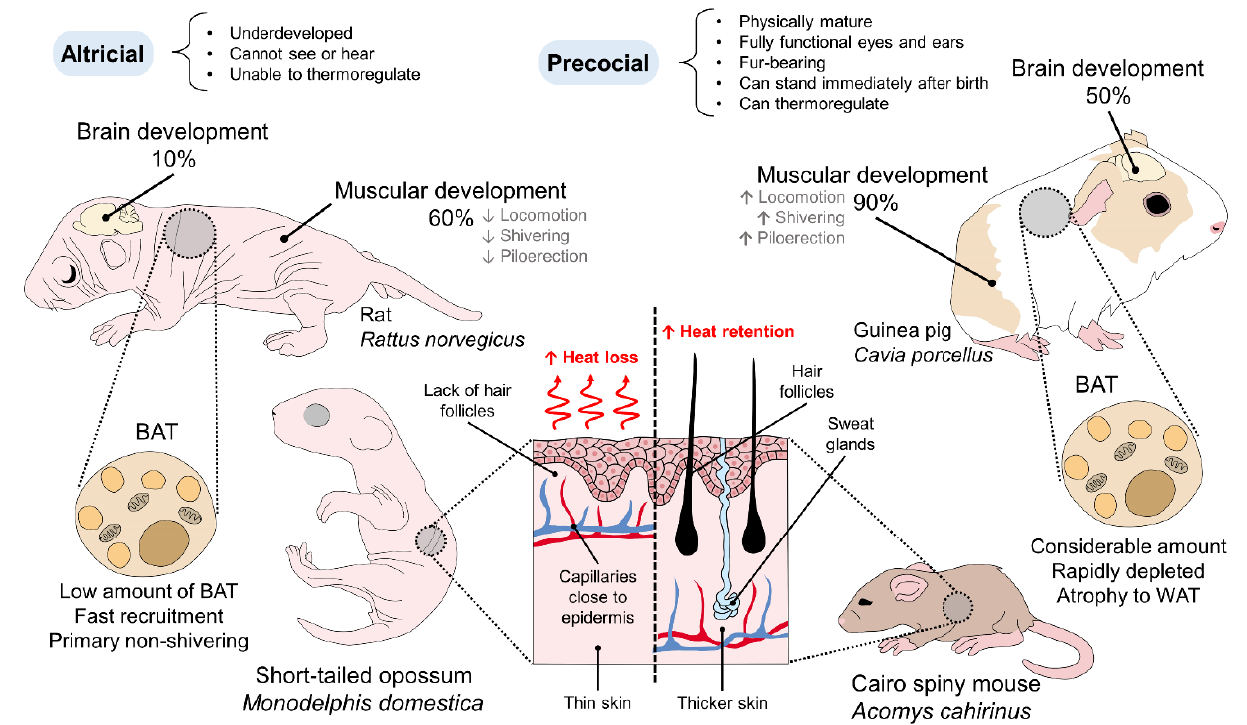
Figure 2. Morphoanatomical differences in altricial and precocial newborn rodents and their influence on thermoregulation. In altricial or underdeveloped Monodelphis domestica and Rattus norvegicus ) and precocial or physically mature species ( Cavia porcellus, Acomys cahirinus ), morphological characteristics promote or hinder thermoregulation. The lack of fur, low amounts of BAT, uncoordinated locomotion, and thin skin with capillaries close to the epidermis contribute to heat loss and susceptibility to hypothermia in altricial species, contrarily to precocial species. BAT: brown adipose tissue; WAT: white adipose tissue.